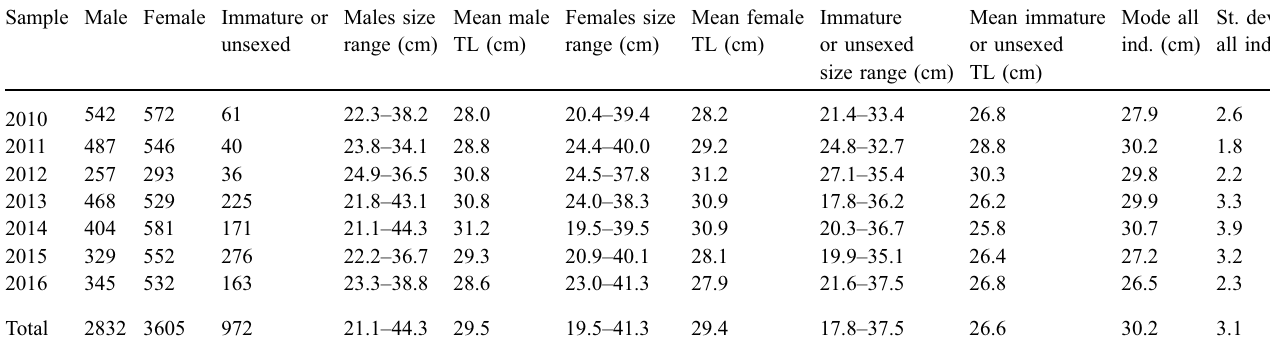
Table 1. Annual summary of Trachurus picturatus sampled monthly from trawler landings at Matosinhos, Portugal. Minimum, maximum, modal lengths and standard deviation are also indicated for each year.